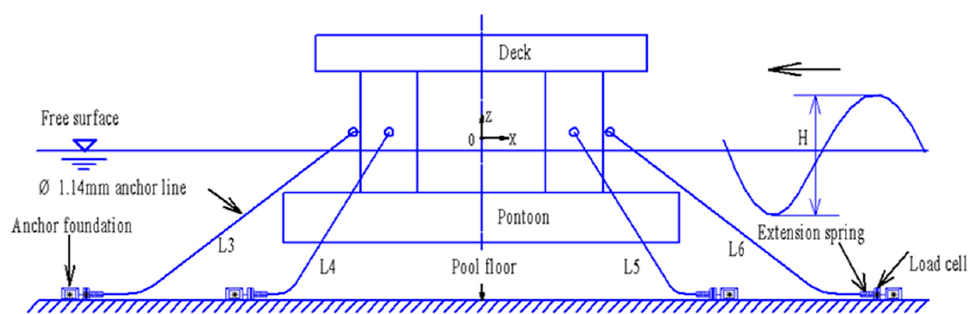
Figure 5. Side-view diagram of the test model after installation.